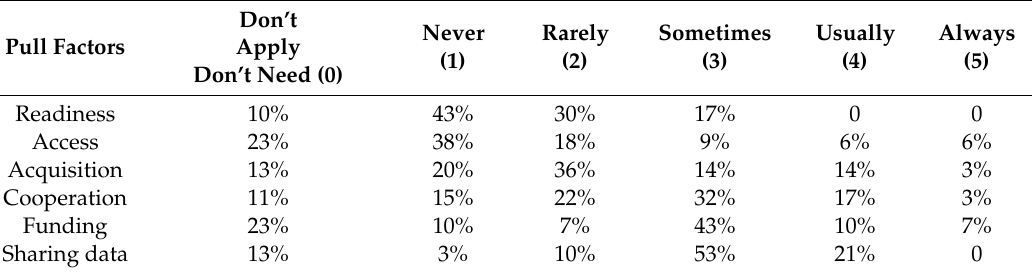
Table 3. Frequency distribution of pull e ff